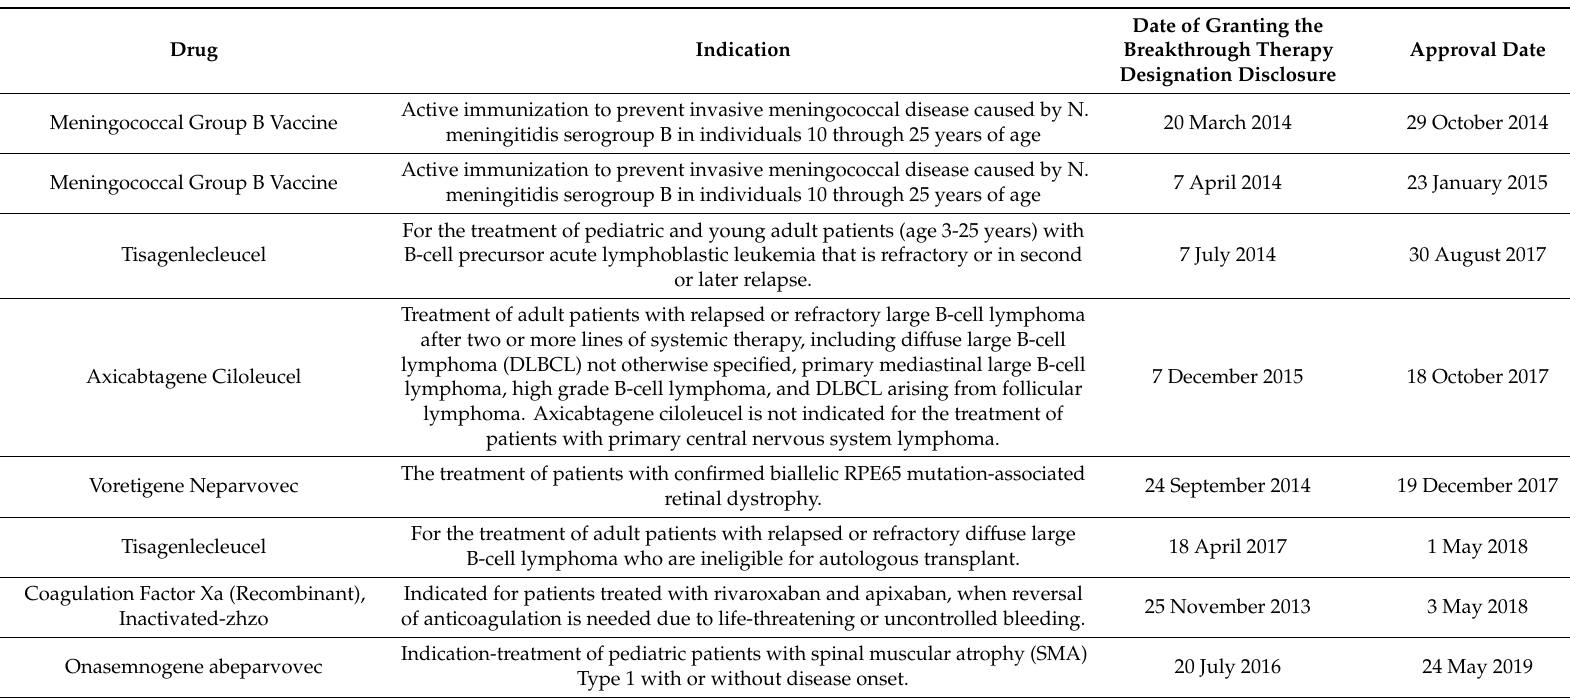
Table 8. Biological medical products that were granted the breakthrough therapy designation, which were granted marketing authorization in the US as of 30 June